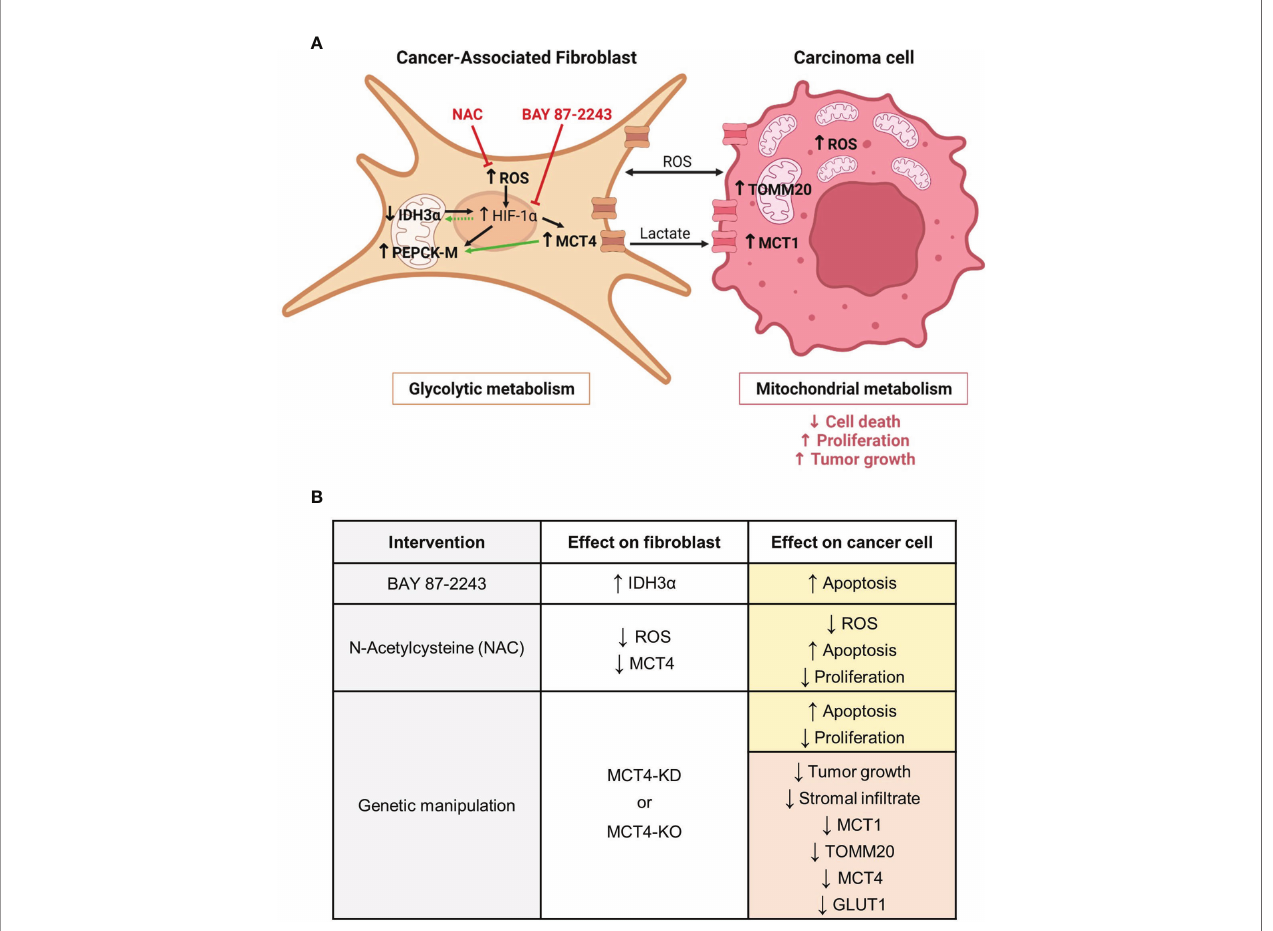
FIGURE 9 | Metabolic compartmentalization in ADT cancers and interventions to modulate fi broblast metabolism and carcinoma cell aggressiveness. (A) We have demonstrated that both in patients and in experimental models of ADT cancers, CAFs are glycolytic, whereas carcinoma cells are mitochondria-rich and have OXPHOS metabolism. We have shown that CAFs have increased levels of ROS. ROS are a mean of communication between metabolic compartments and known inducers of HIF-1 a stabilization in CAFs. HIF-1 a drives glycolysis and transcriptionally regulates MCT4 and PEPCK-M. We have shown that CAFs have upregulation of MCT4 and PEPCK-M, and that PEPCK-M expression may also be regulated by MCT4. MCT4 is located in the plasma membrane and is the main exporter of glycolysis-derived lactate. Loss of IDH3 a is also a driver of HIF-1 a stabilization. We have shown that CAFs have downregulation of IDH3 a expression and that elevated levels of HIF-1 a may in turn maintain the low expression of IDH3 a . Both upregulation of MCT4 and loss of IDH3 a are markers of glycolysis in CAFs, and we de fi ne PEPCK-M as another possible marker of glycolytic reprogramming in CAFs. We have demonstrated that CAF glycolytic reprogramming can be targeted using a HIF-1 a inhibitor (BAY 87-2243) and an antioxidant (NAC). In the carcinoma cell compartment, we have demonstrated that the presence of glycolytic CAFs induces ROS, MCT1 and TOMM20 expression and drives carcinoma cell aggressiveness, as seen by decreased cell death and increased proliferation, and tumor growth. In bold are the elements studied in our report. Black arrows indicate previously described pathways. Green arrows indicate the novel fi ndings reported here. Red inhibitor arrows indicate NAC and BAY 87-2243 targets. (B) We have modulated CAF glycolytic metabolism and ADT carcinoma cell aggressiveness by means of pharmacological and genetic interventions. The HIF-1 a inhibitor BAY 87-2243 rescued IDH3 a expression in CAFs and induced carcinoma cell apoptosis. The antioxidant NAC reduced ROS levels and MCT4 expression in CAFs, and in carcinoma cells it reduced ROS levels, induced apoptosis and decreased proliferation. Genetic knock-down (KD) or knock-out (KO) of MCT4 in CAFs increased apoptosis and decreased proliferation in carcinoma cells, and reduced growth and the expression of MCT1, TOMM20, MCT4 and GLUT1 in tumors. Yellow boxes indicate effects in vitro . Red boxes indicate effects in vivo . CAF, Cancer-associated fi broblast; ROS, reactive oxygen species; HIF-1 a , hypoxia inducible factor 1 alpha; MCT4, monocarboxylate transporter 4; IDH3 a , isocitrate dehydrogenase 3 alpha; PEPCK-M, mitochondrial phosphoenolpyruvate carboxykinase; NAC, N-acetyl cysteine; MCT1, monocarboxylate transporter 1; TOMM20, translocase of the outer mitochondrial membrane 20. Created with